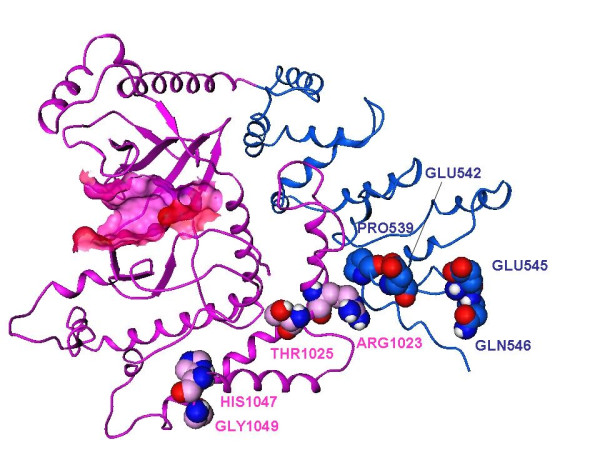
Ribbon representation of the PI3Kα. Ribbon representation of the PI3Kα helical domain (blue) and kinase domain (magenta) extracted from the p110α/p85α complex (PDB Code: 2RD0; Berman et al. (2000) [45]; Huang et al. (2007) [46]). Displayed in CPK representations are sites of major oncogenic mutations: Pro539, Glu542, Glu545 and Gln546 in the helical domain (blue); Arg1023, Thr1025, His1047 and Gly1049 in the kinase domain (pink). The ATP binding site in the kinase domain is highlighted with a surface.